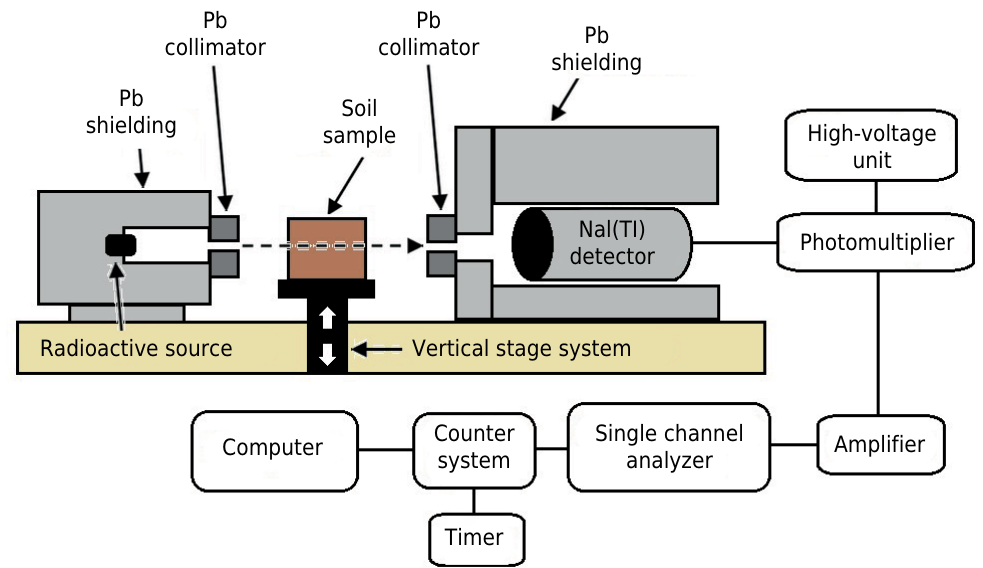
Figure 3. Scheme of the gamma-ray attenuation